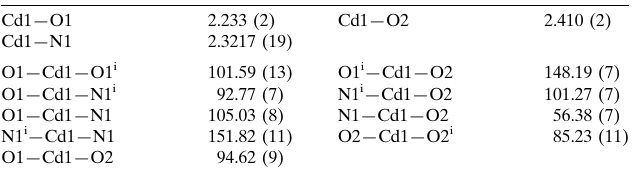
Selected geometric parameters (A˚ , (cid:2) ).